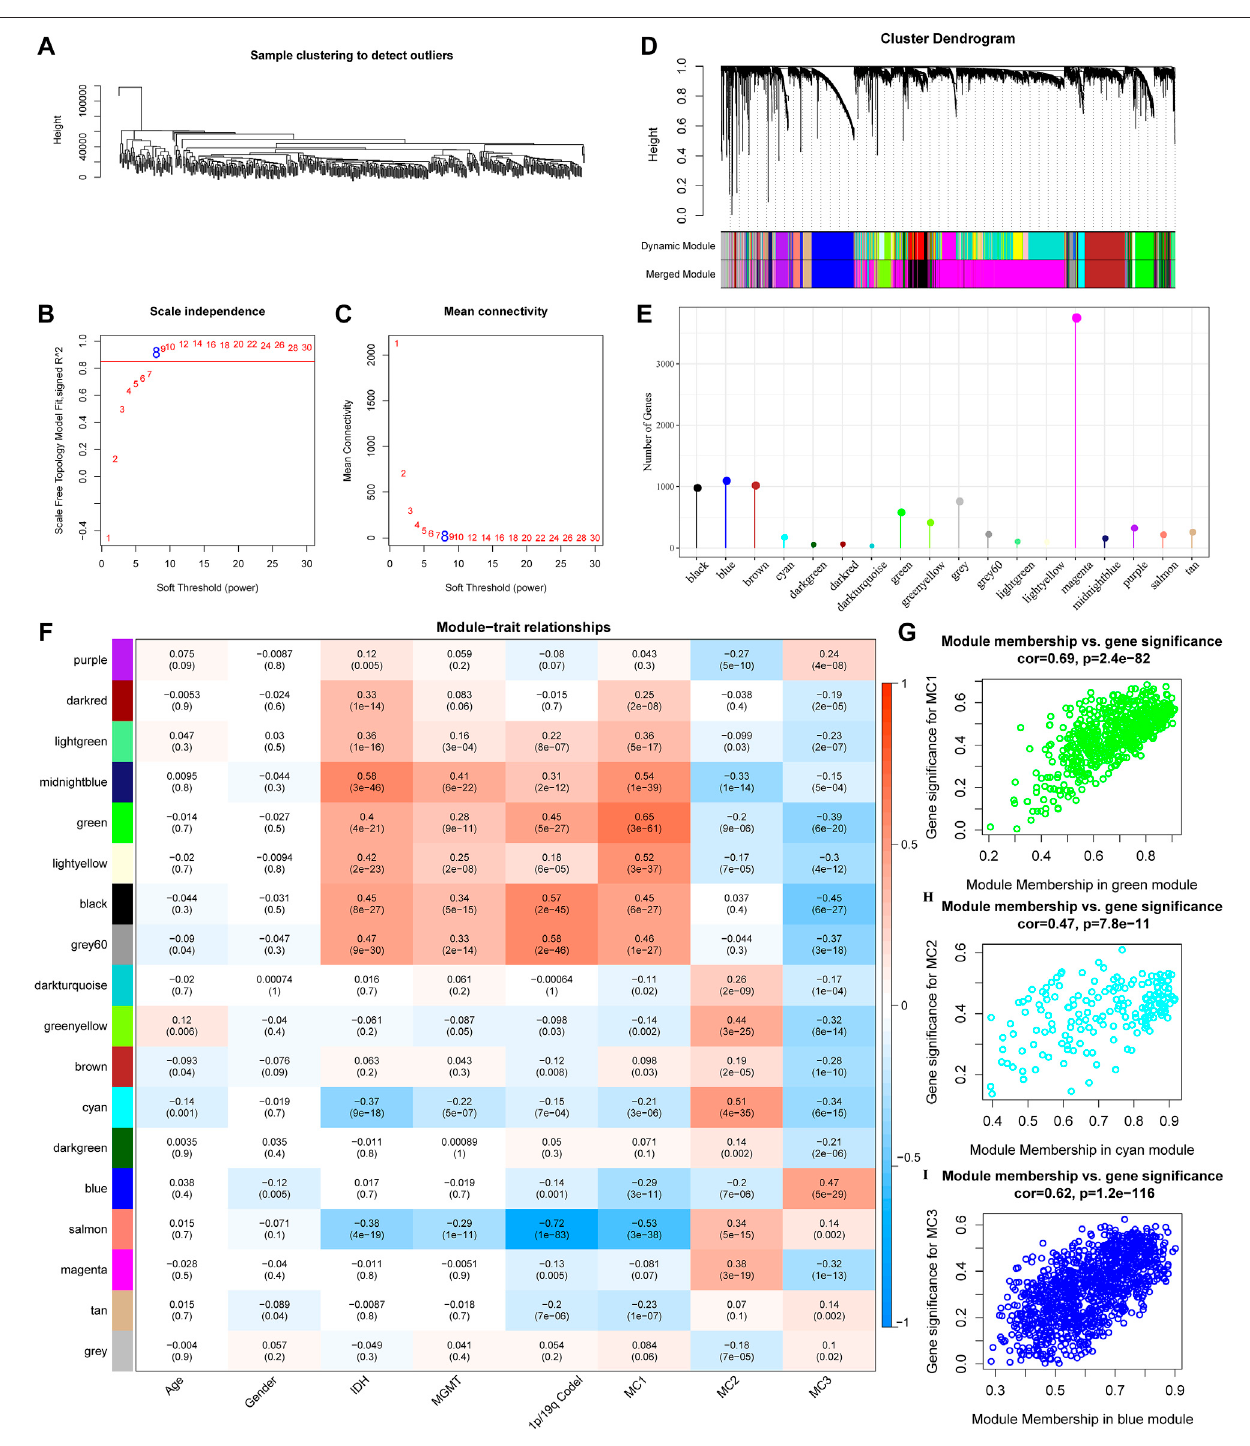
Frontiers in Cell and Developmental Biology |